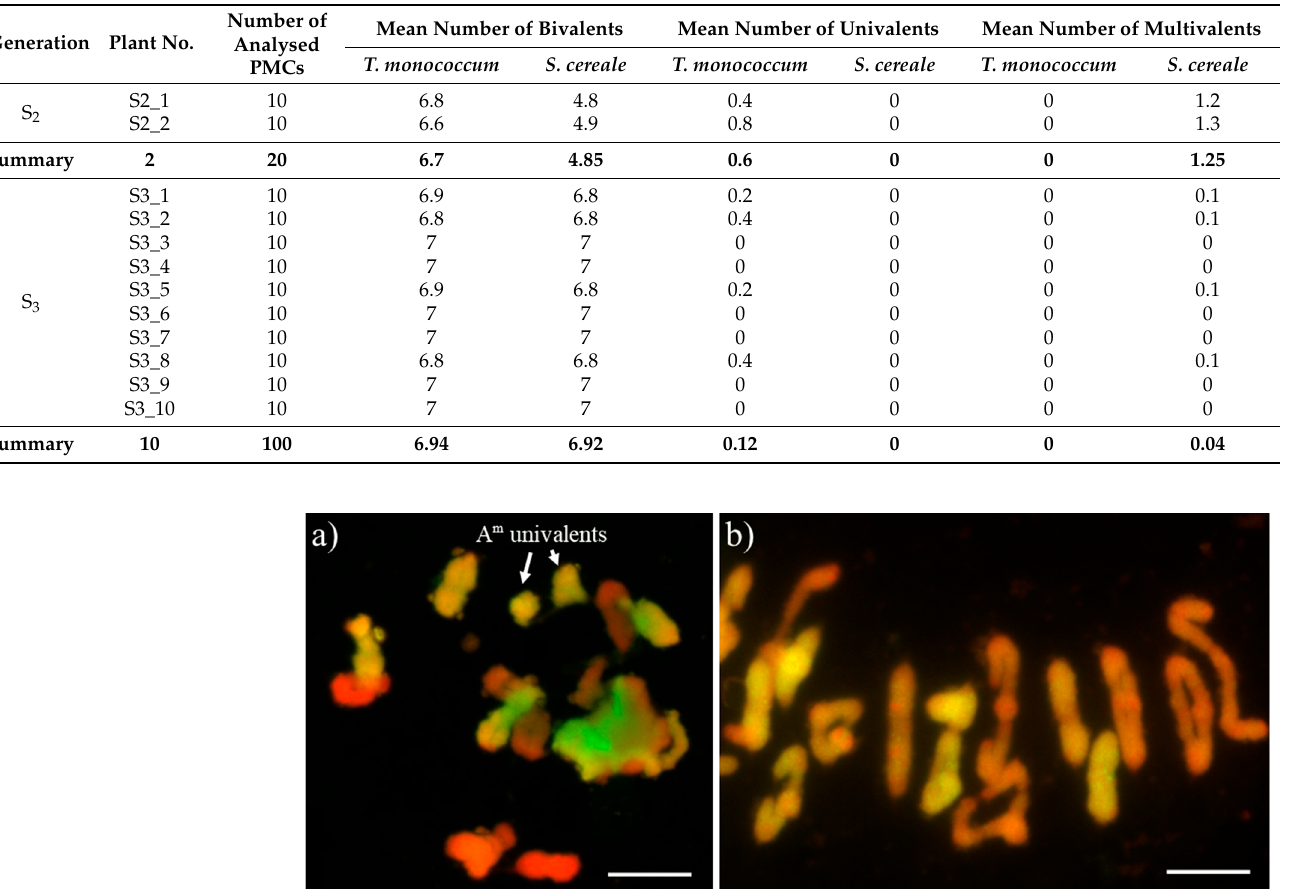
Table 4. Chromosome configurations during meiosis of Pollen Mother Cells (PMCs) at metaphase I analysed for S 2 and S 3 generation plants.